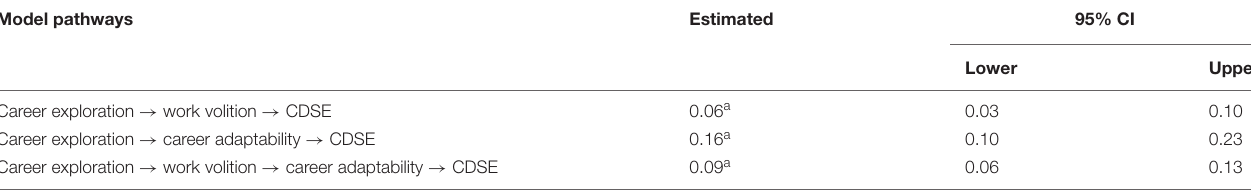
TABLE 2 | Standardized indirect effects and 95% CI for the mediation model. Model